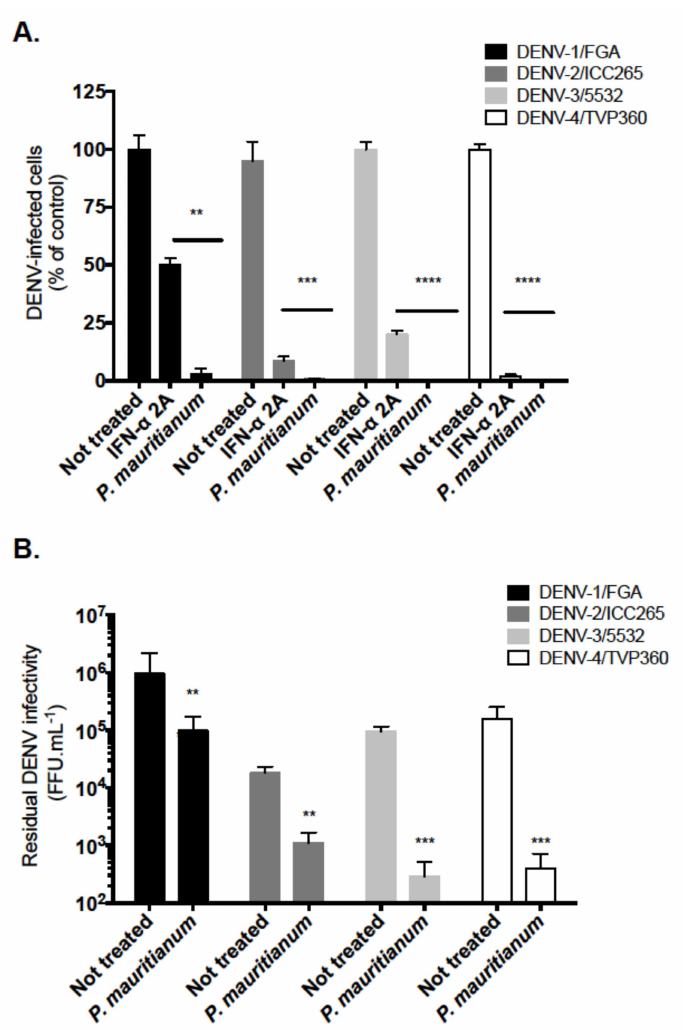
Figure 6. The P. mauritianum extract inhibits the infection of four DENV clinical isolates representative of the four serotypes. Four DENV serotypes (DENV-1, 2, 3 and 4) were pre-incubated with the P. mauritianum extract for 1 h at 37 ◦ C. ( A ) Huh7.5 cells were infected for 48 h with DENV at the di ff erent MOI 0.2, 2, 0.5 and 2 for DENV 1–4, respectively. Recombinant IFN- α 2A (200 IU mL − 1 ) was added 2 h post-infection and used as a positive control. The percentage of E positive cells was evaluated using the Operetta High-Content Imaging System (PerkinElmer). The results are the means ± SD of three independent experiments. ( B ) The residual infectious particles were titrated in C6 / 36 cells using a foci-forming immunodetection assay. The data represent the means ± SD from three independent experiments. A one-way ANOVA and Dunnett’s test for multiple comparisons were used for the statistical analysis (** p < 0.01; *** p < 0.001; **** p <